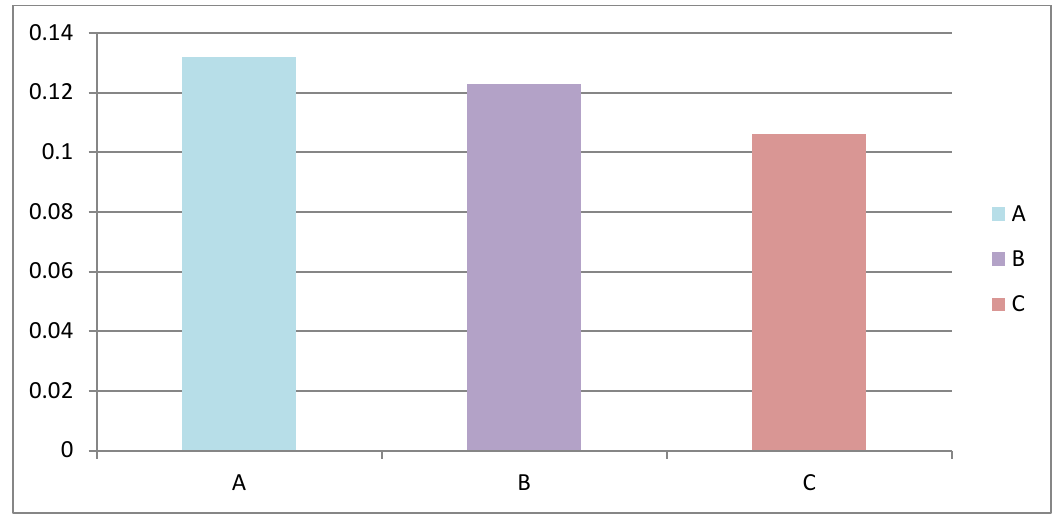
Fig. 19. The value of adhered cells, A mono monomer, B di monomer tri